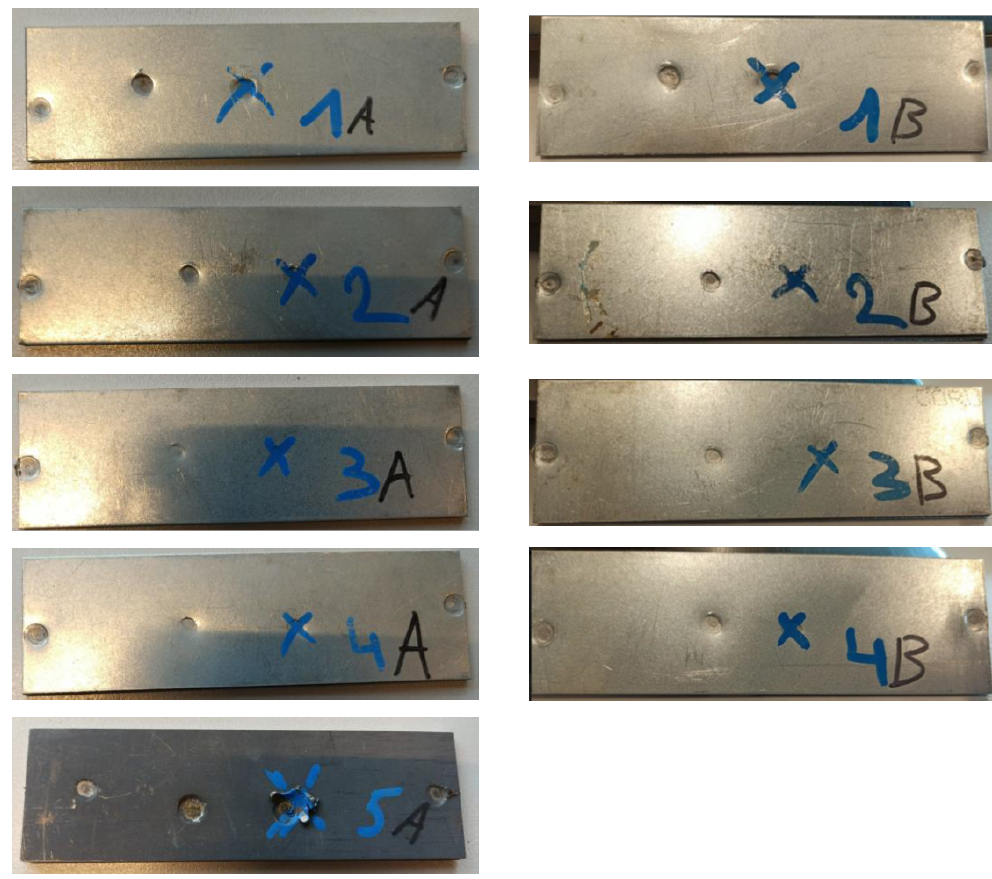
Figure 1. Nine samples, divided into two series. The A-series consists of four samples with a thickness of 2.5 mm (1–4) and sample 5A is 3.15 mm thick. The B-series only consists of four samples with a thickness of 2.5 mm. The spot weld highlighted by the blue cross is the inspected spot weld for each sample. Table 2. Parameters used during light heating measurements. A representation of the parameters can be found in Figure